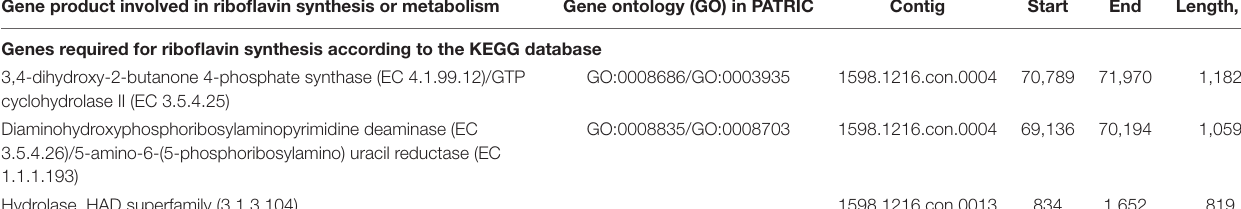
TABLE 2 | Riboflavin biosynthesis pathway genes present in the L. reuteri AMBV339 genome. Gene product involved in riboflavin synthesis or